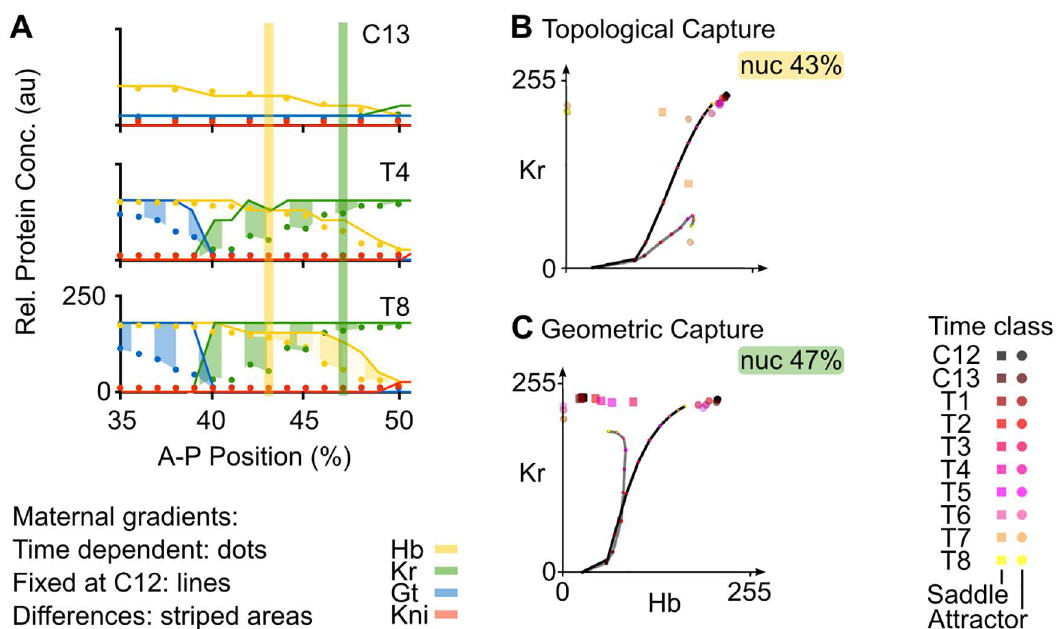
Fig 6. Positioning the Hb-Kr interface. Output of the non-autonomous gene circuit (dots) versus the same model without maternalgradientdecay (lines) shown at cleavagecycle C13 and C14A (time classes T4 and T8) for nucleibetween35– 52% A–P position.Axes and colouringscheme as in Fig 3B. Yellow and green vertical bars mark the nucleiat 43% and 47%A–P positionshown in (B) and (C) respectively. (B) Phase portrait for nucleusat 43% position. (C) Phase portrait for nucleusat 47% position. Phase portraits are shown as two-dimensional projectionsonto the plane definedby Hb (x-axis) and Kr (y-axis) concentrations (in arbitrary units, au). Non-autonomous trajectories are shown as grey lines and autonomous trajectories, as black lines. Point attractors are representedby spheres and saddlespoints by squares. Small coloured dots on the trajectories indicatethe position in phasespace (Hb and Kr concentrations) of the trajectory at different time points. Colouringof attractors and trajectory positionsindicatestime class (see key). Other steady states have been omitted for clarity, since they do not shape trajectories in these nuclei. See text for details.